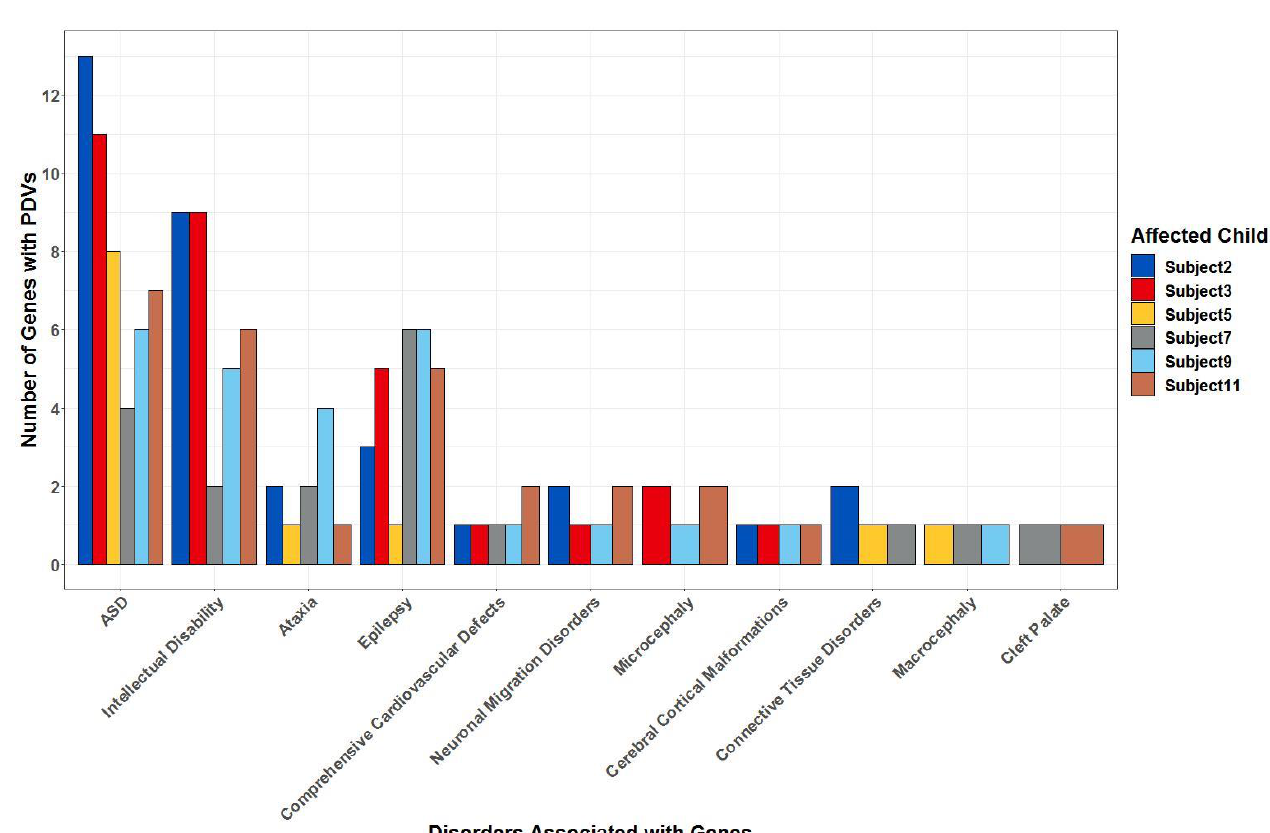
Figure 5. Number of genes with possibly damaging variants (PDVs) in each affected child associated with disorders of interest. Shown are the total number of genes with PDVs on the y-axis, that are also evidenced to be involved in the conditions on the x-axis. For autism spectrum disorder (ASD), evidence was based on the Simons Foundation for Autism Research Institute gene list. For other conditions, evidence was based on inclusion on clinical testing panels from Clinical Laboratory Improvement Amendments (CLIA) approved and accredited commercial laboratories.